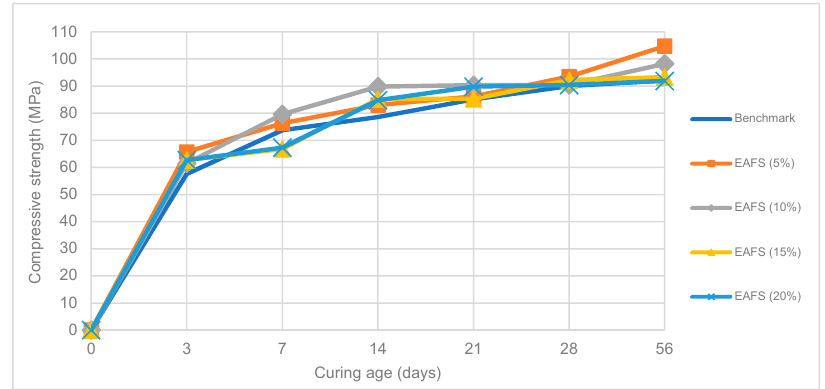
Figure 14. Variation of compressive strength for samples containing various dosages of EAFS compared to the benchmark SCC mix.